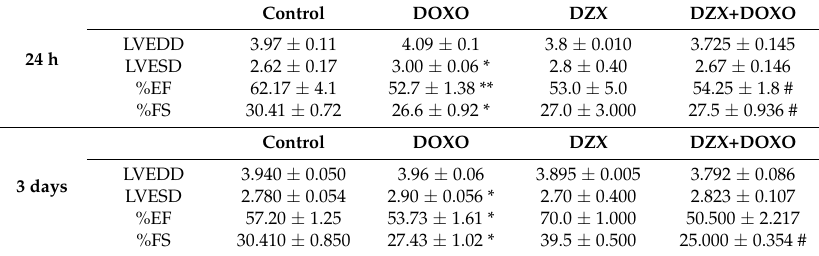
Table 1. Effect of DOXO (10 mg/kg; i.p.) or DZX (20 mg/kg; i.p.) or combined DZX+DOXO treatment on Ejection Fraction (% EF), Fraction Shortening (% FS), Left Ventricular End-Diastolic Diameter (LVEDD) and on Left Ventricular End-Systolic Diameter (LVESD), after a single administration (1th group), two administrations (2nd group), or three administrations (3rd group). Results were expressed as mean ± S.E.M. from 4 mice/group. Data were analyzed by Student’s t -test. * p < 0.05, and ** p < 0.005 vs. control; and # p < 0.05 DZX+DOXO vs.